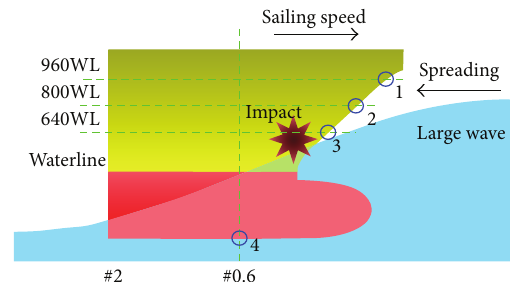
Figure 1: Model equipment.